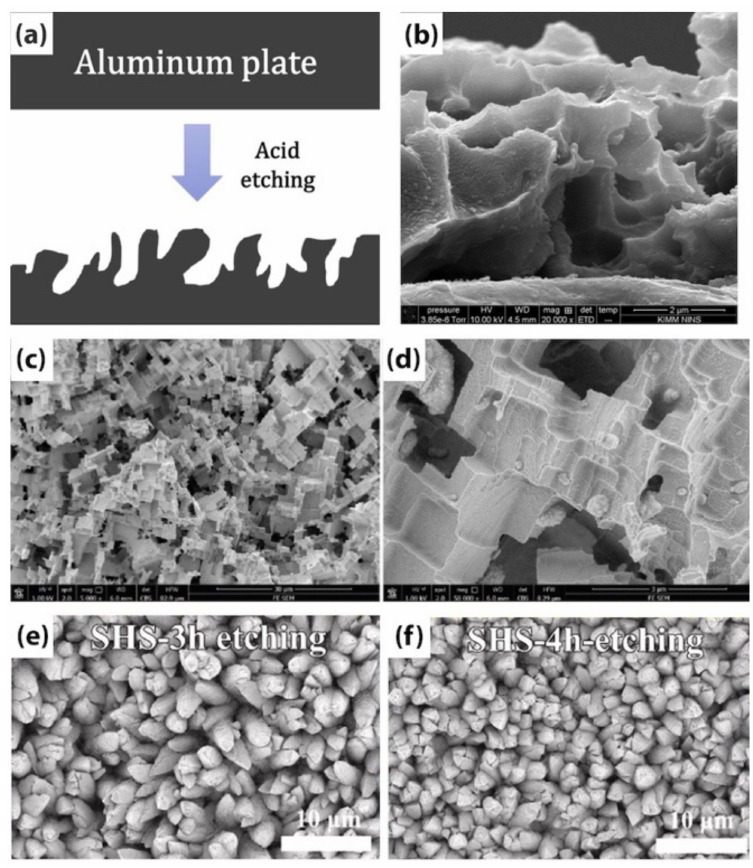
Figure 12. ( a ) Schematic illustration of creating surface roughness by chemical etching of an Al plate with an acidic solution of HCl, isopropanol and DI water; ( b – f ) the SEM images of hierarchical structures on an Al surface after modification in ( b ) HCl solution (Reprinted from [67] with permission from Elsevier); ( c , d ) FeCl 3 solution (Reprinted with permission from [66]. Copyright {2021} American Chemical Society); and ( e , f ) ammonia solution (Reprinted from [68] with permission from